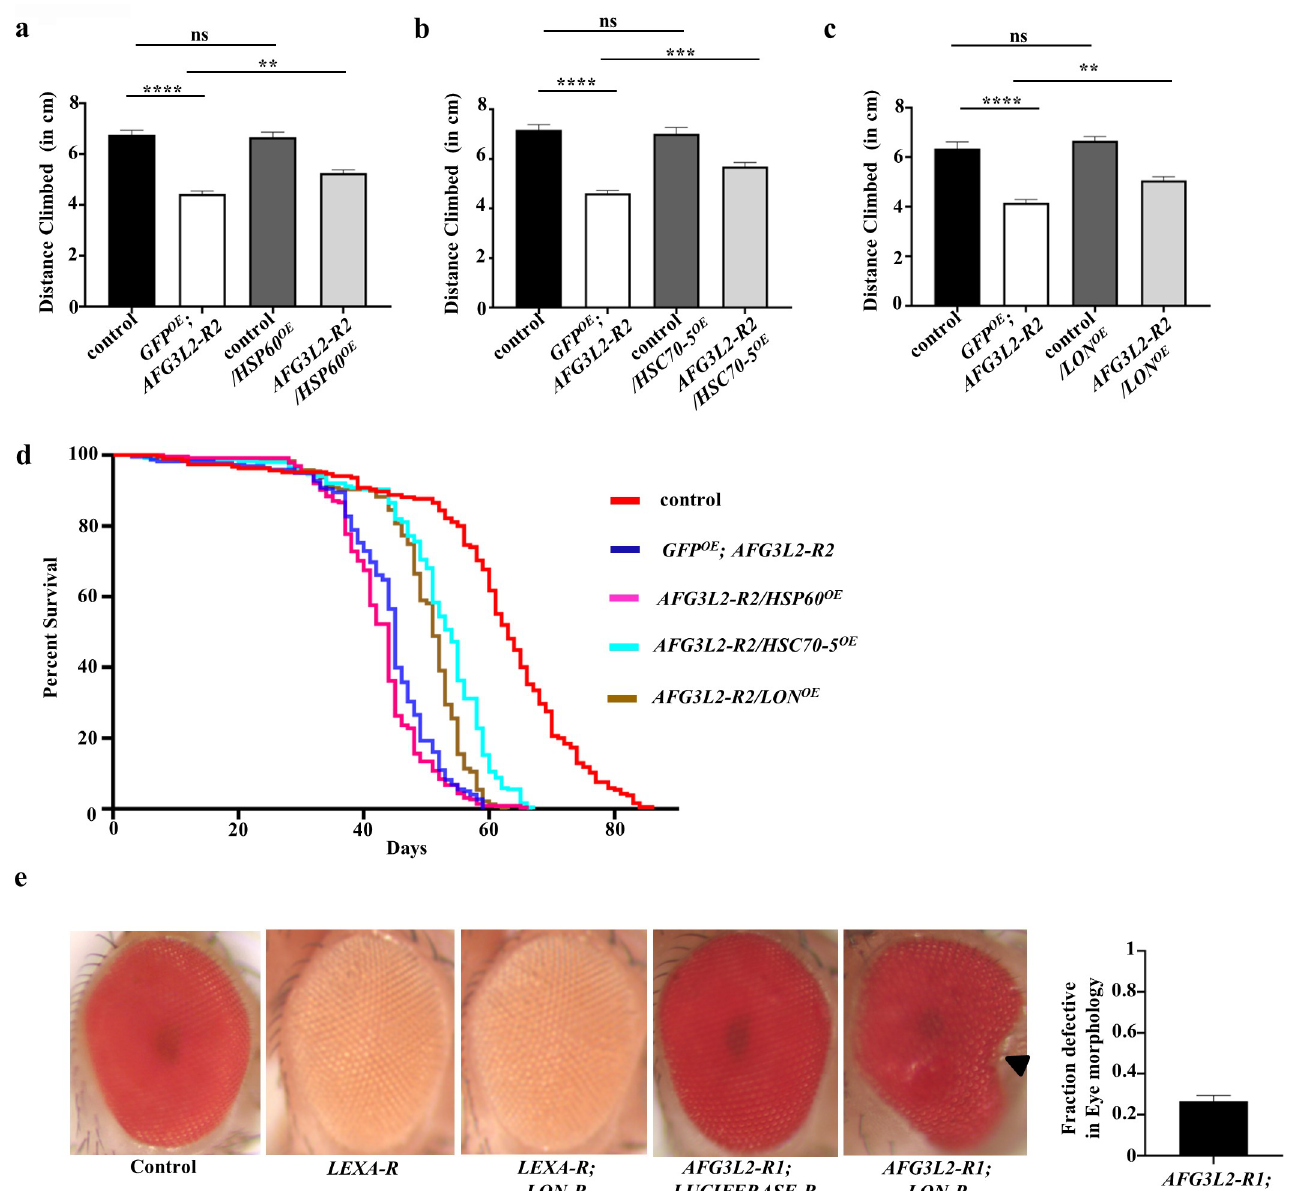
Fig 9. Overexpression of mito-UPR components partially rescues the locomotion and lifespan defects of AFG3L2 -deficient animals. a. Climbing performance of 1-day old adult controls (elav-Gal4/UAS- GFP ; UAS- LUCIFERASE RNAi; N = 101), AFG3L2 -deficient animals: GFP OE ; AFG3L2-R2 (elav-Gal4/ UAS- GFP ; UAS- AFG3L2-R2 RNAi; N = 94), control flies overexpressing Hsp60: control /HSP60 OE (elav-Gal4; UAS- LUCIFERASE RNAi / UAS- HSP60 ; N = 92) and AFG3L2 -deficient animals overexpressing Hsp60: AFG3L2-R2 /HSP60 OE (elav-Gal4; UAS- AFG3L2-R2 RNAi / UAS- HSP60 ; N = 100) ( �� p < 0.005, ���� p < 0.0001 by one way ANOVA Tukey’s test for multiple comparison). b. Climbing performance of 1-day old adult controls (elav-Gal4/UAS- GFP ; UAS- LUCIFERASE RNAi; N = 63), AFG3L2 -deficient animals: GFP OE ; AFG3L2-R2 (elav-Gal4/UAS- GFP ; UAS- AFG3L2-R2 RNAi; N = 65), control flies overexpressing Hsc70-5: Control /HSC70-5 OE (elav-Gal4; UAS- LUCIFERASE RNAi / UAS- HSC70-5 ; N = 48) and AFG3L2 -deficient animals overexpressing Hsc70-5: AFG3L2-R2 / HSC70-5 OE (elav-Gal4; UAS- AFG3L2-R2 RNAi / UAS- HSC70-5 ; N = 66) ( ��� p < 0.0005, ���� p < 0.0001 by one way ANOVA Tukey’s test for multiple comparison). c. Climbing performance of 1-day old adult controls (elav-Gal4/UAS- GFP ; UAS- LUCIFERASE RNAi; N = 53),), AFG3L2 -deficient animals: GFP OE ; AFG3L2-R2 (elav-Gal4/UAS- GFP ; UAS- AFG3L2-R2 RNAi; N = 64), control flies overexpressing Lon: control/ LON OE (elav-Gal4/ TRiP-OE LON ; UAS- LUCIFERASE RNAi/UAS- dCAS9-FLAG-VPR ; N = 74) and AFG3L2 -deficient animals overexpressing Lon: AFG3L2-R2 / LON OE (elav-Gal4/ TRiP-OE LON ; UAS- AFG3L2-R2 RNAi /UAS- dCAS9-FLAG-VPR ; N = 86). ( �� p < 0.005, ���� p < 0.0001 by one way ANOVA Tukey’s test for multiple comparison). d. Kaplan–Meier survival curves of controls (elav-Gal4/UAS- GFP ; UAS- LUCIFERASE RNAi; N = 185, 50% survival 67 days), AFG3L2 -deficient animals: GFP OE ; AFG3L2-R2 (elav-Gal4/UAS- GFP ; UAS- AFG3L2-R2 RNAi; N = 218, 50% survival 45 days), AFG3L2 -deficient animals overexpressing Hsp60: AFG3L2-R2/ HSP60 OE (elav-Gal4; UAS- AFG3L2-R2 RNAi / UAS- HSP60 ; N = 224, 50% survival 44 days), AFG3L2 -deficient animals overexpressing Hsc70-5: AFG3L2-R2 /